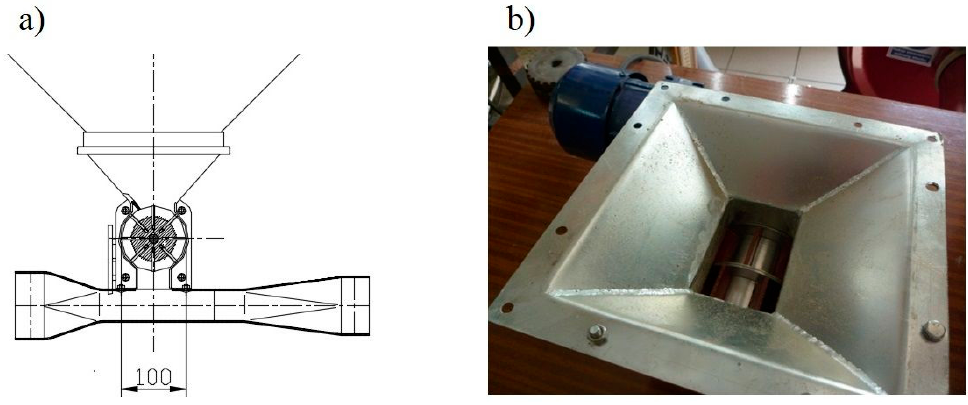
Figure 6. Seed dispensing unit ( a ) diagram, ( b ) prototype view.